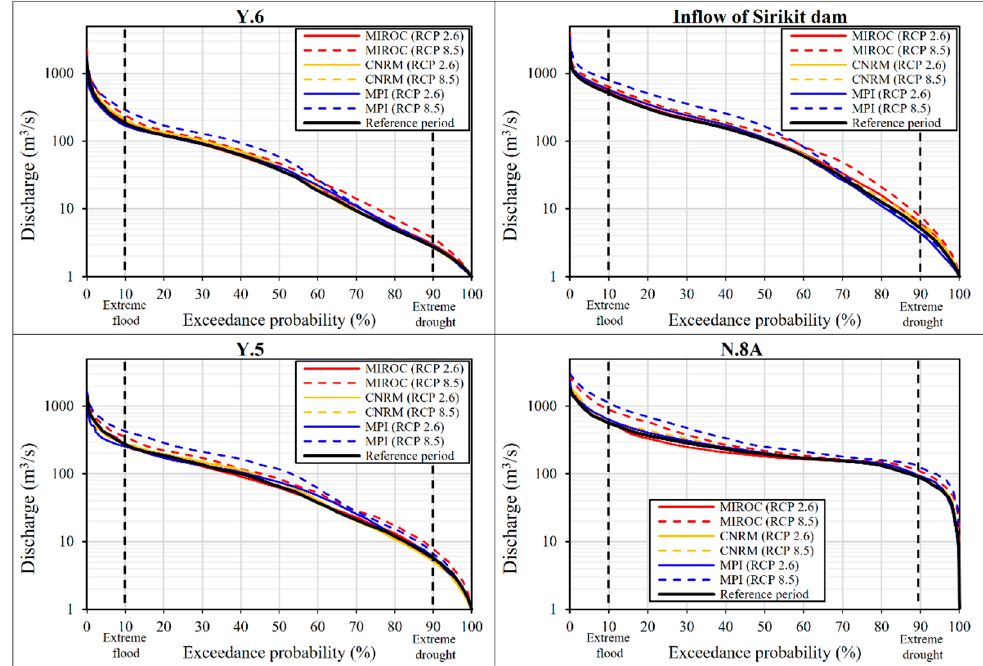
Figure 11. Flow Duration Curve in the far future (2071–2095) under scenarios RCP 2.6 and RCP 8.5 compared with the reference period.